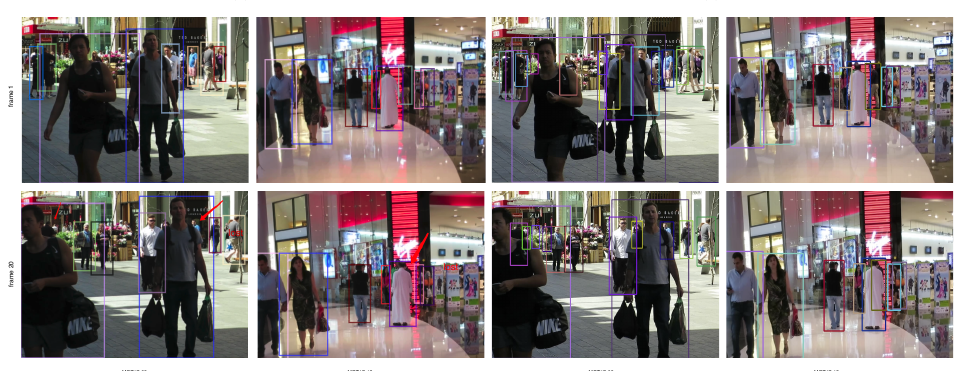
Figure 3. Comparison of results before and after postponing NMS. The position pointed by the red arrow is an untraceable object after being